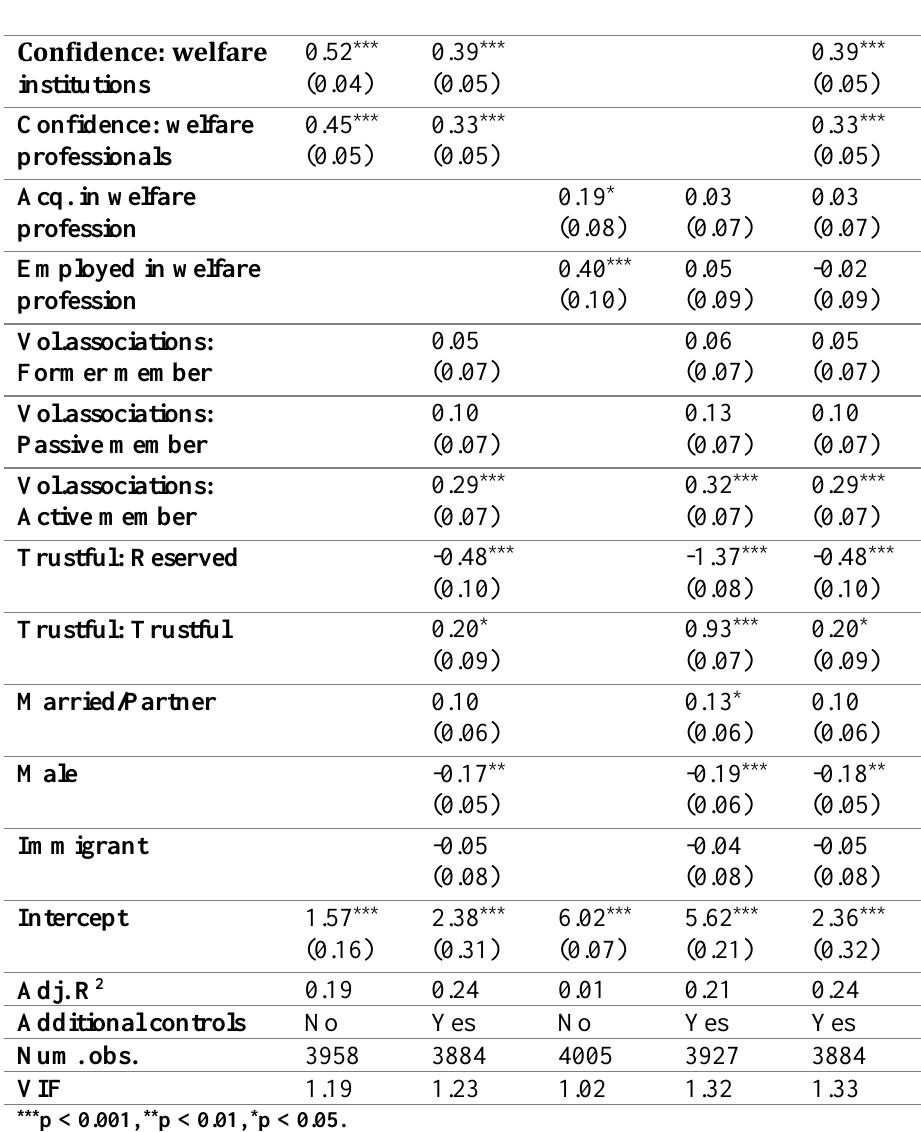
Table 2. Indicators of confidence in institutions, professionals and acquaint- ance with welfare professionals regressed (OLS) on generalized